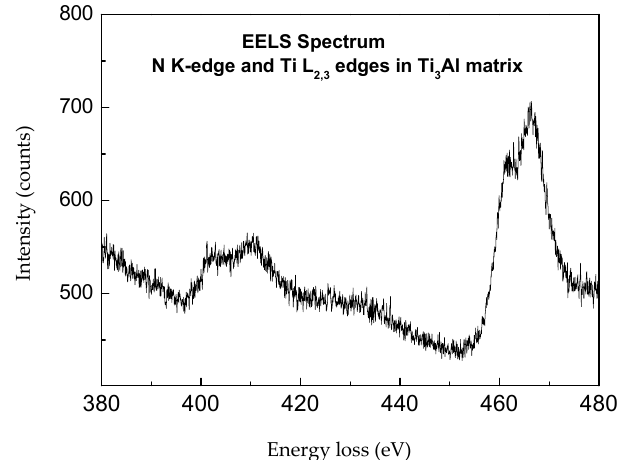
Figure 14. EELS spectrum in the sublayer adjacent to the substrate, K Edge N (399 eV) and L edge Ti (455 eV).